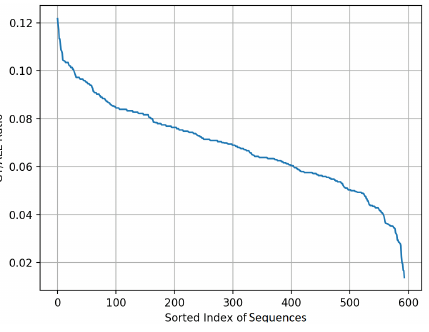
Figure 4. The ratio of labels vs. total number of samples for all the 594 sequences shown in the decreasing order. Table 3. Statistics of the subjects featured in the 200 selected sequences for the eye-segmentation subset. Gender